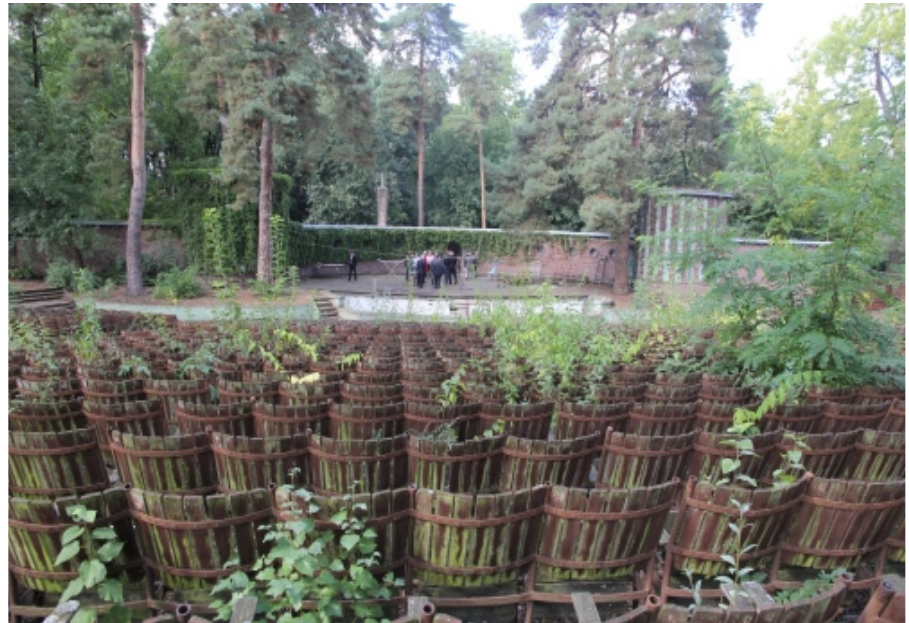
Figure 7. Open-air theatre in 2000s. Source: own collection.